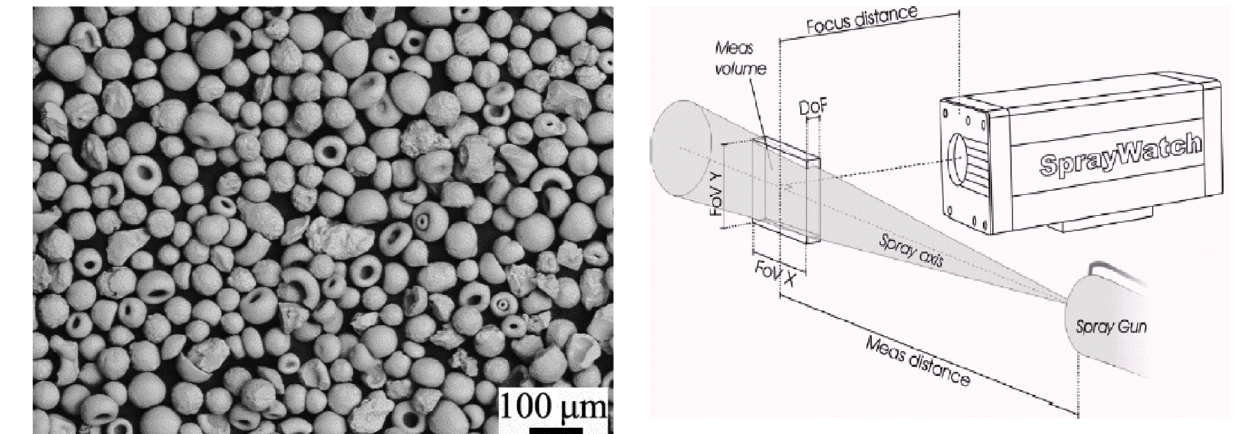
Figure 1: The morphology of original commercial ZrO 2 -8 wt% Y 2 O 3 .